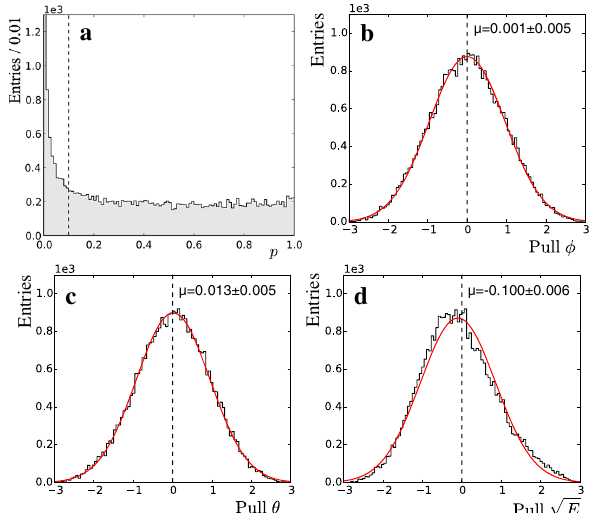
Fig. 1 Confidence level and exemplary pull distributions obtained from the kinematic fit for the hypothesis ¯ pp → K + K − π 0 . The con- fidence level a shows a flat distribution towards large p values and an enhancement for low values, which is caused by background or mis- reconstructed events. The pull distributions for the angles φ , θ ( b , c ) and the square root of the energy ( d ) for reconstructed photons show a Gaussian shape centered at zero with a width of approximately one. The mean values μ are extracted from the fit (red). All four distribu- tions show the good quality of the selected data and indicate a well understood error